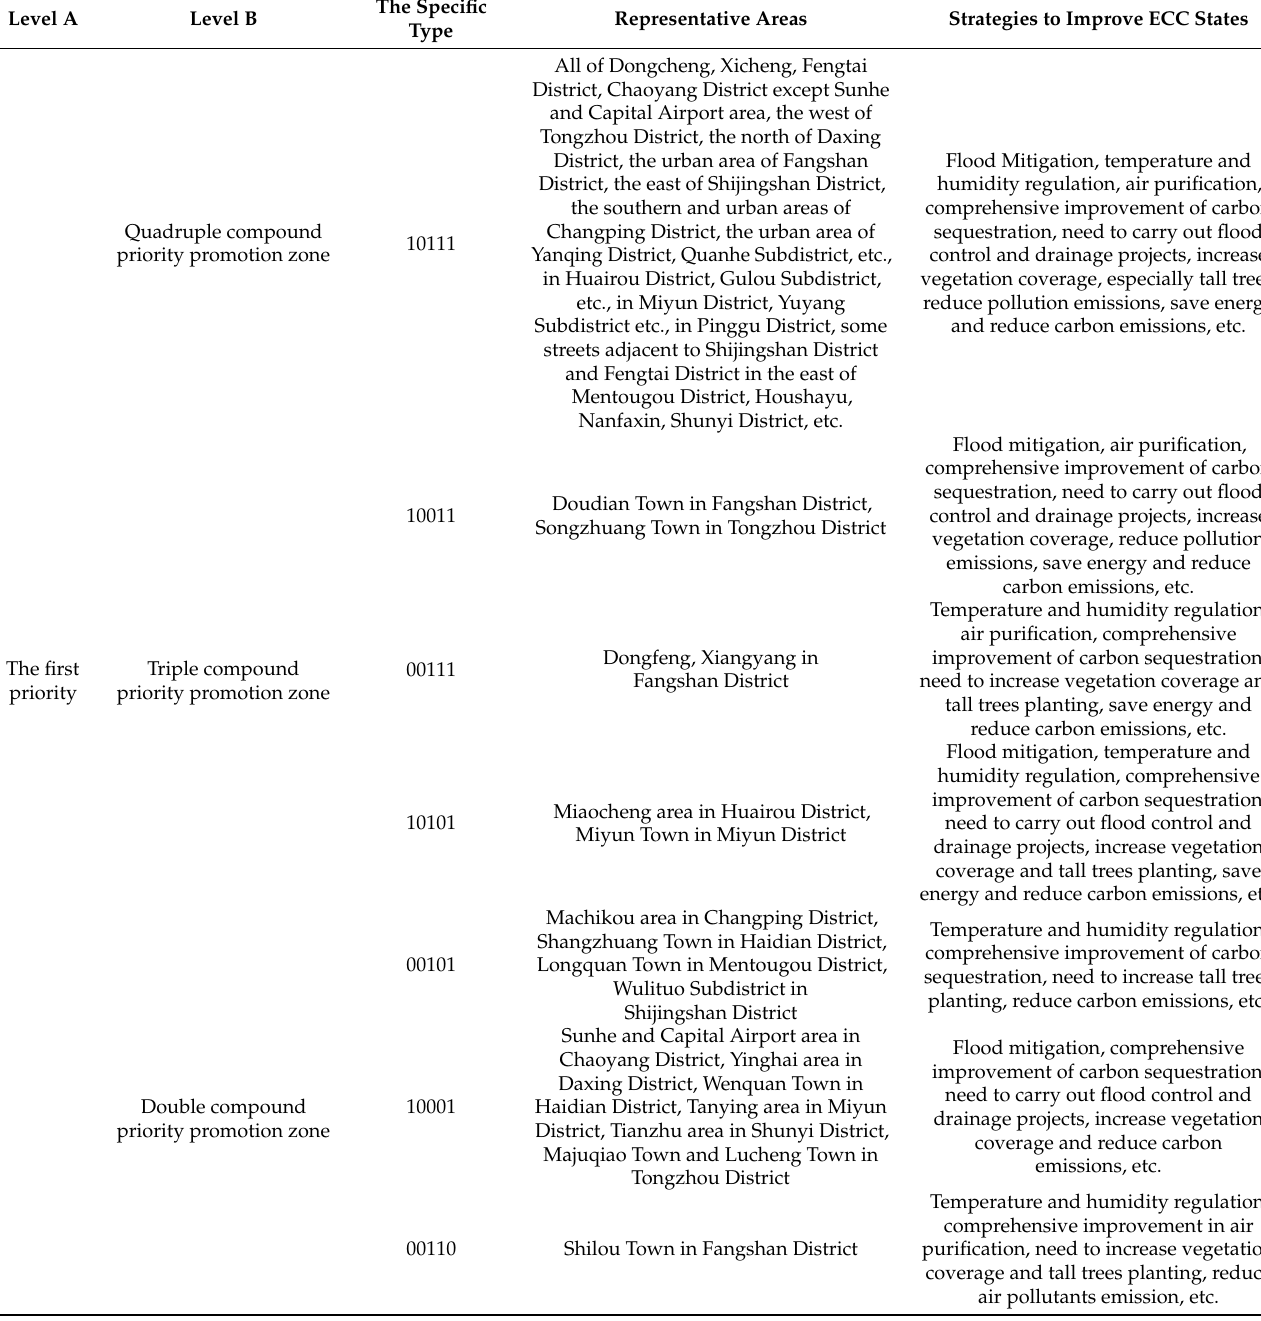
Table 5. The different characteristics and strategies for different ECC matching